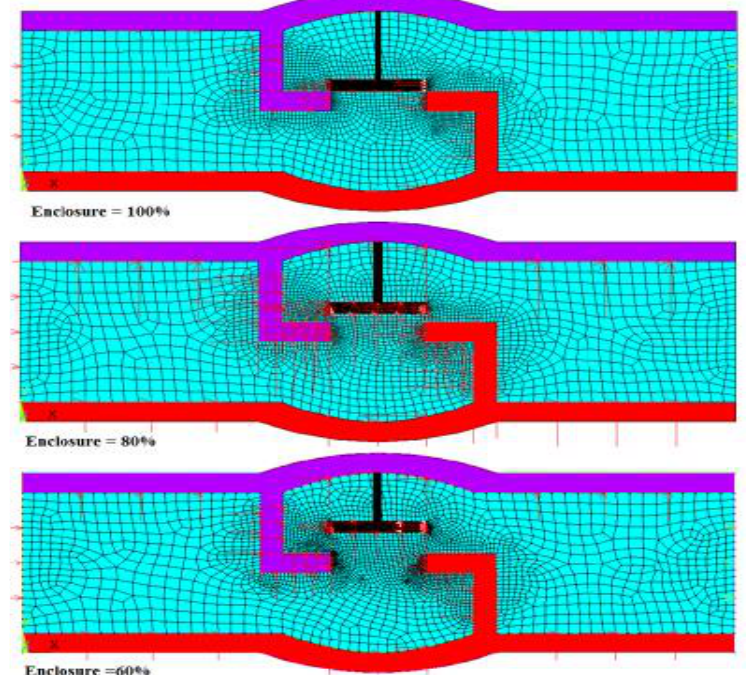
Fig. 5. Flow domain at different enclosure ratio.